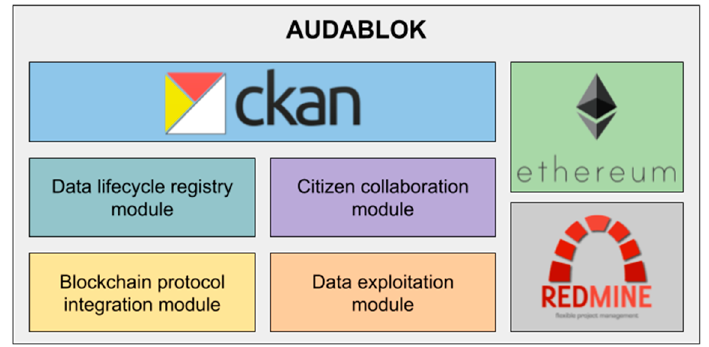
Figure 1. AUDABLOK conceptual